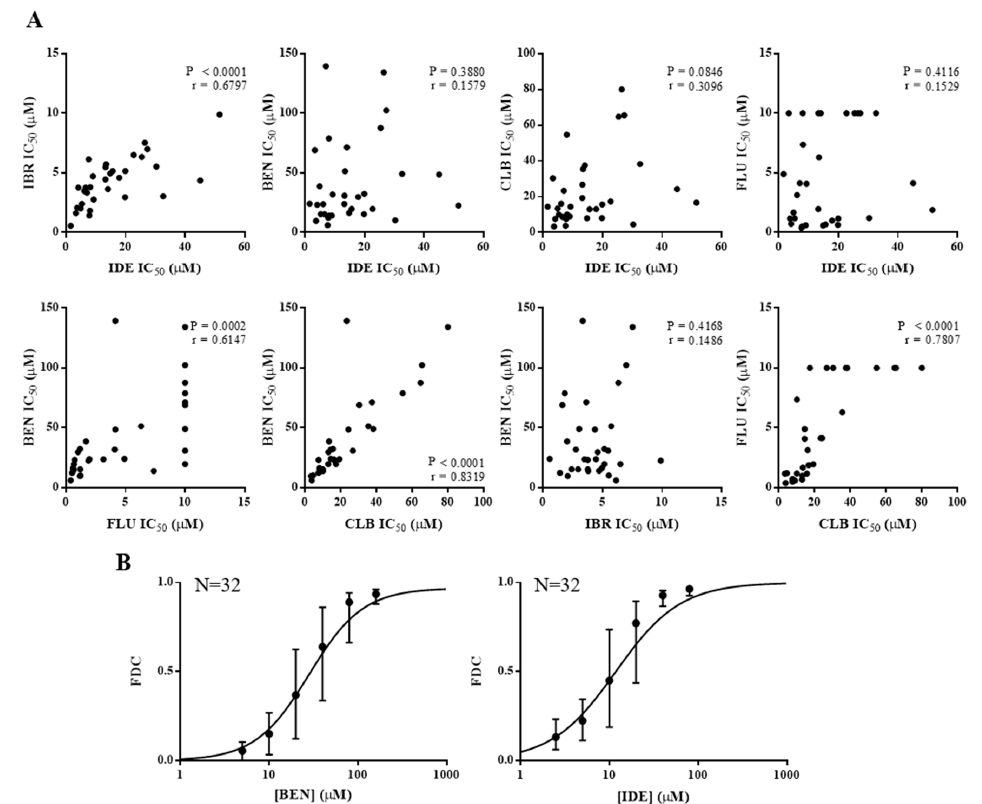
Figure 1. Idelalisib (IDE) is not cross-resistant with chemotherapies bendamustine (BEN), chlorambucil (CLB), or fludarabine (FLU) but is cross-resistant with ibrutinib (IBR), and IDE and BEN have similar sigmoidal dose-response curves. ( A ) Correlation of the concentration required to inhibit cell viability by 50% (IC 50 ) between the di ff erent chronic lymphocytic leukemia (CLL) drugs. IC 50 s were calculated 72 h post drug treatment of primary CLL samples. ( B ) Dose-response curves of the median and interquartile range of 32 unique primary CLL samples treated with single agent BEN or IDE for 72 h (FDC = fraction of dead